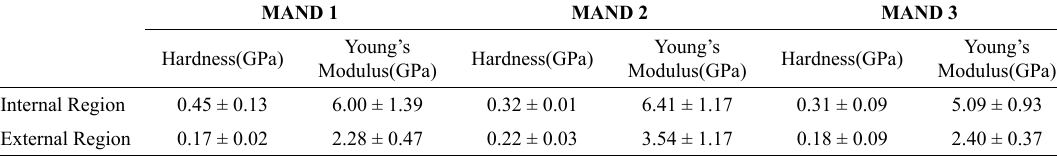
Table 2. Mechanical properties of the samples obtained by nanoindentation.